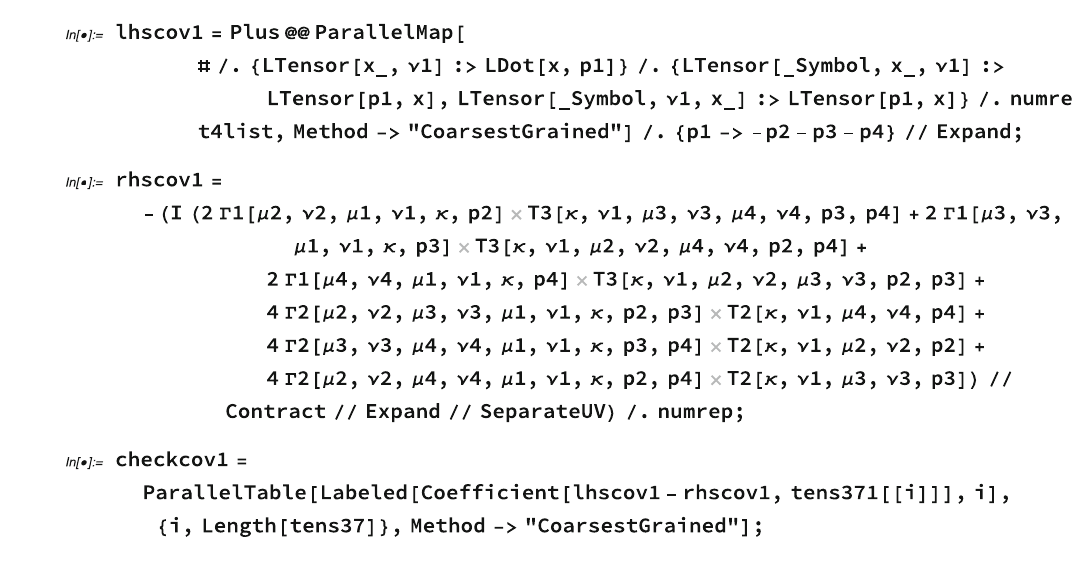
Ward identity in (35). If smaller than the threshold prec = 10 − 8 param- eter, the result is subsequently chopped out of the list. The final result is an empty list, so the test is